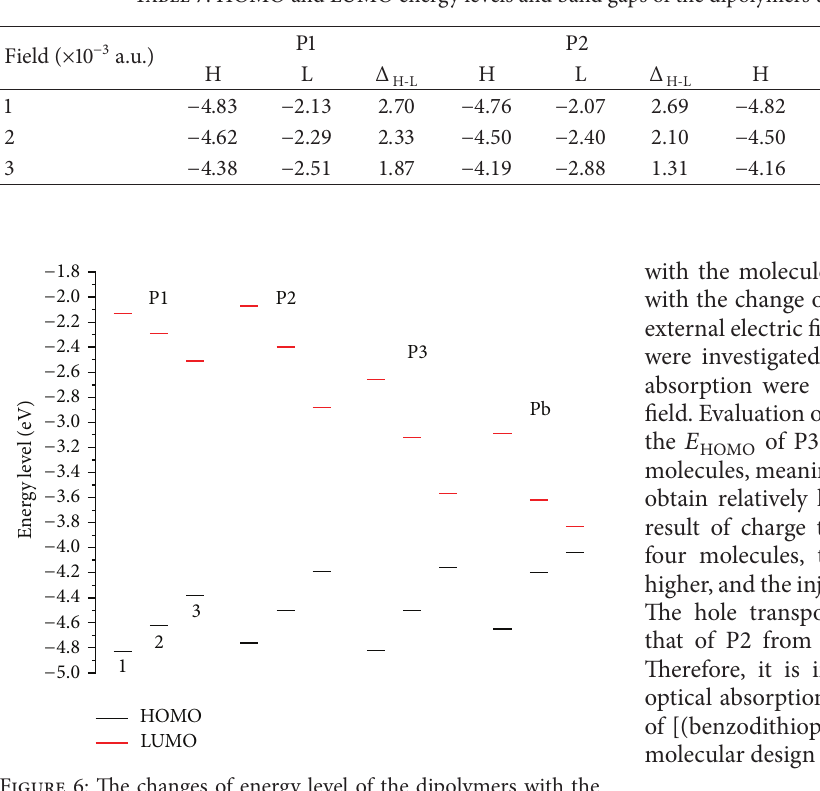
Figure 6: The changes of energy level of the dipolymers with the increasing electric field.